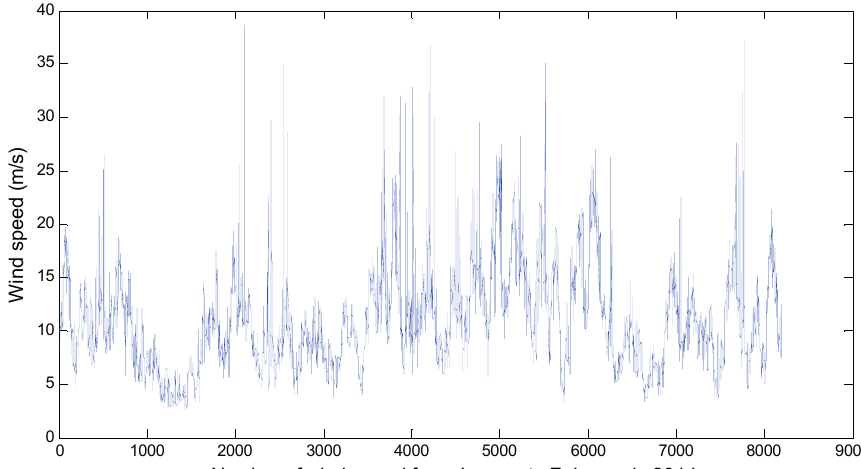
Figure 4. The distribution of wind speed recorded from January to February in 2014 in Sotavento wind